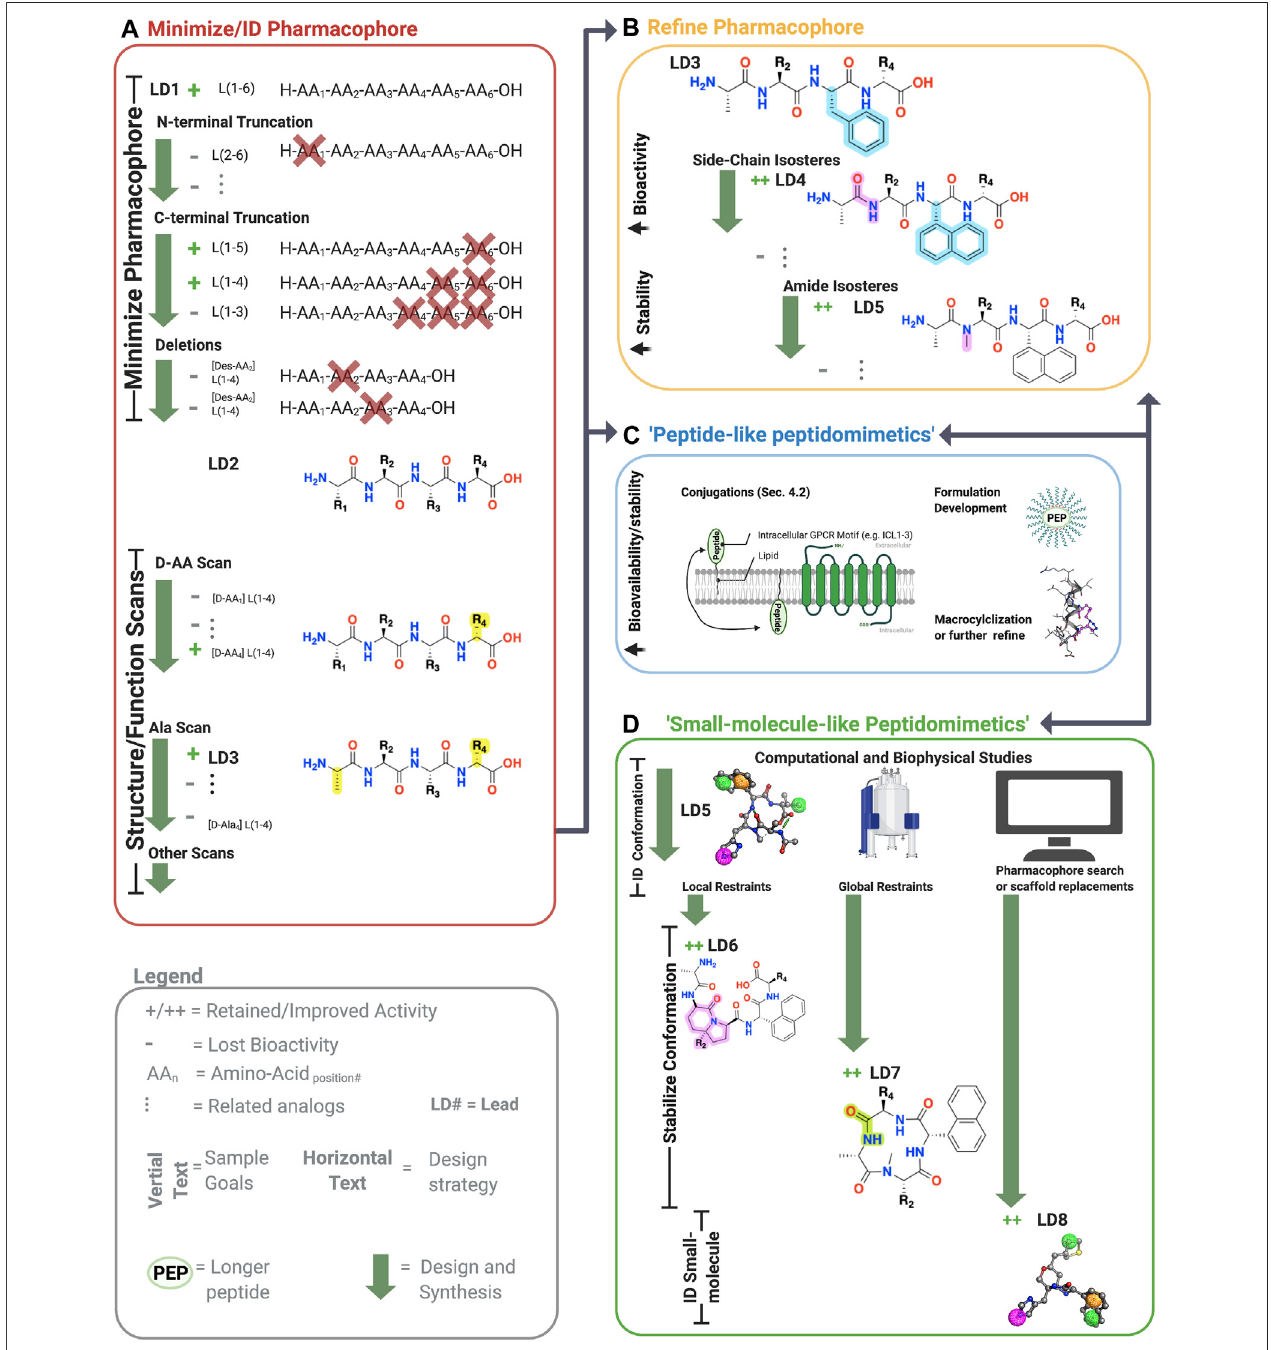
FIGURE 3 | Sample work fl ow for peptidomimetic drug development. Sample work fl ow for peptidomimetic drug design of a hypothetical six-amino acid peptide lead LD1[L(1-6)]. (A) First, pharmacophore minimization occurs involving truncations of N-terminus/C-terminus and a deletion scan. In this case, the N-terminal truncation of AA 1 abolished bioactivity (gray), and thus L(1-6) was retained. The C-terminal removal of AA 5 and AA 6 retained activity but not AA 4 yielding L(1-4) or LD2. Next, deletion of the remaining amino acids is tested to further reduce the lead ’ s molecular weight. In the example, deleting either AA 2 or AA 3 abolished activity, leaving the lead unchanged L(1-4). Finally, sequential amino acid scans can identify the conformational and side-chain requirements for the pharmacophore. In the example, AA 1 → alanine (A) and L*-AA 4 → D*-AA 4 retained activity, yielded [ala 1 , D-AA 4 ] L(1-4), referred to LD3. At this point, one can perform additional scans or progress to step B, C, or D. (B) The pharmacophore and bioactivity can be further re fi ned depending on the goals. In our example, a side-chain isostere of the F 3 improved bioactivity, while amide N-methylation improved metabolic stability, yielding LD4 and LD5, respectively. In principle, any modi fi cation can alter bioactivity or stability. (C) Peptide-like peptidomimetics of longer or less stable sequences can be optimized through various conjugations, such as lipidation to improve membrane